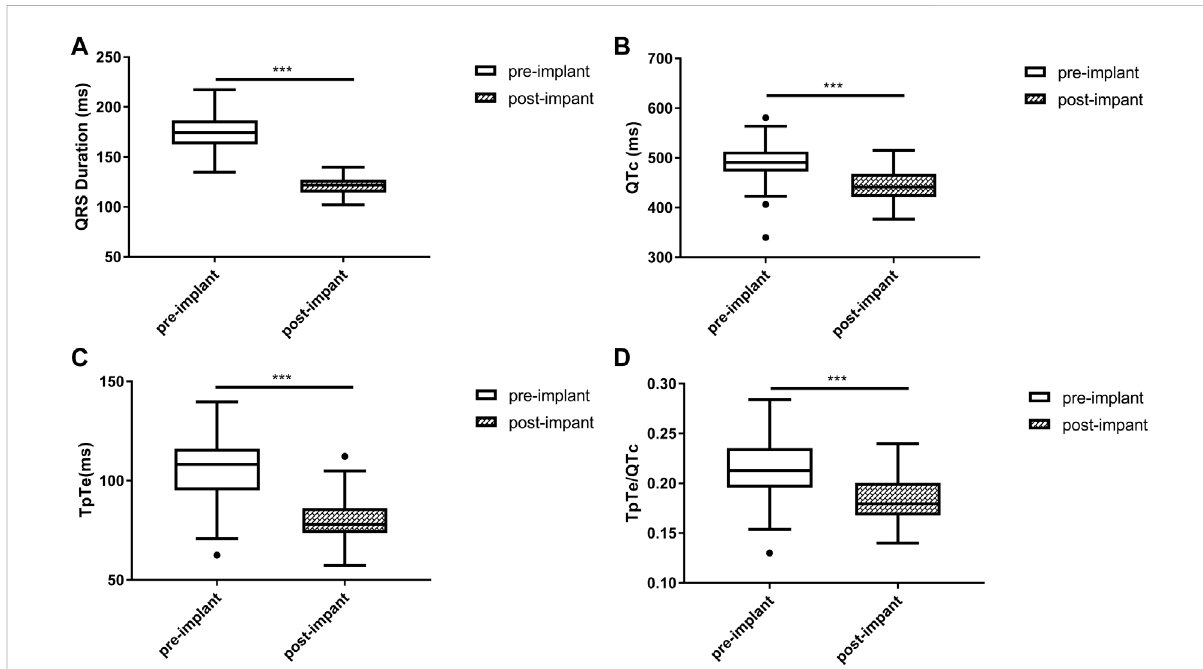
FIGURE 2 Changes inQRSduration (A) , QTc (B) ,TpTe (C) ,TpTe/QTc (D) before and after LBBAP inpatients with wide QRSbut notpaced rhythm( n = 40). (Box plots exhibited the smallest nonoutlier, fi rst quartile, median, third quartile, and largest non-outlier of each variable from bottom to top. LBBAP left bundle branch area pacing; QTc, QT corrected measurement; TpTe, Tpeak-Tend interval. * p < 0.05, ** p < 0.01, *** p <